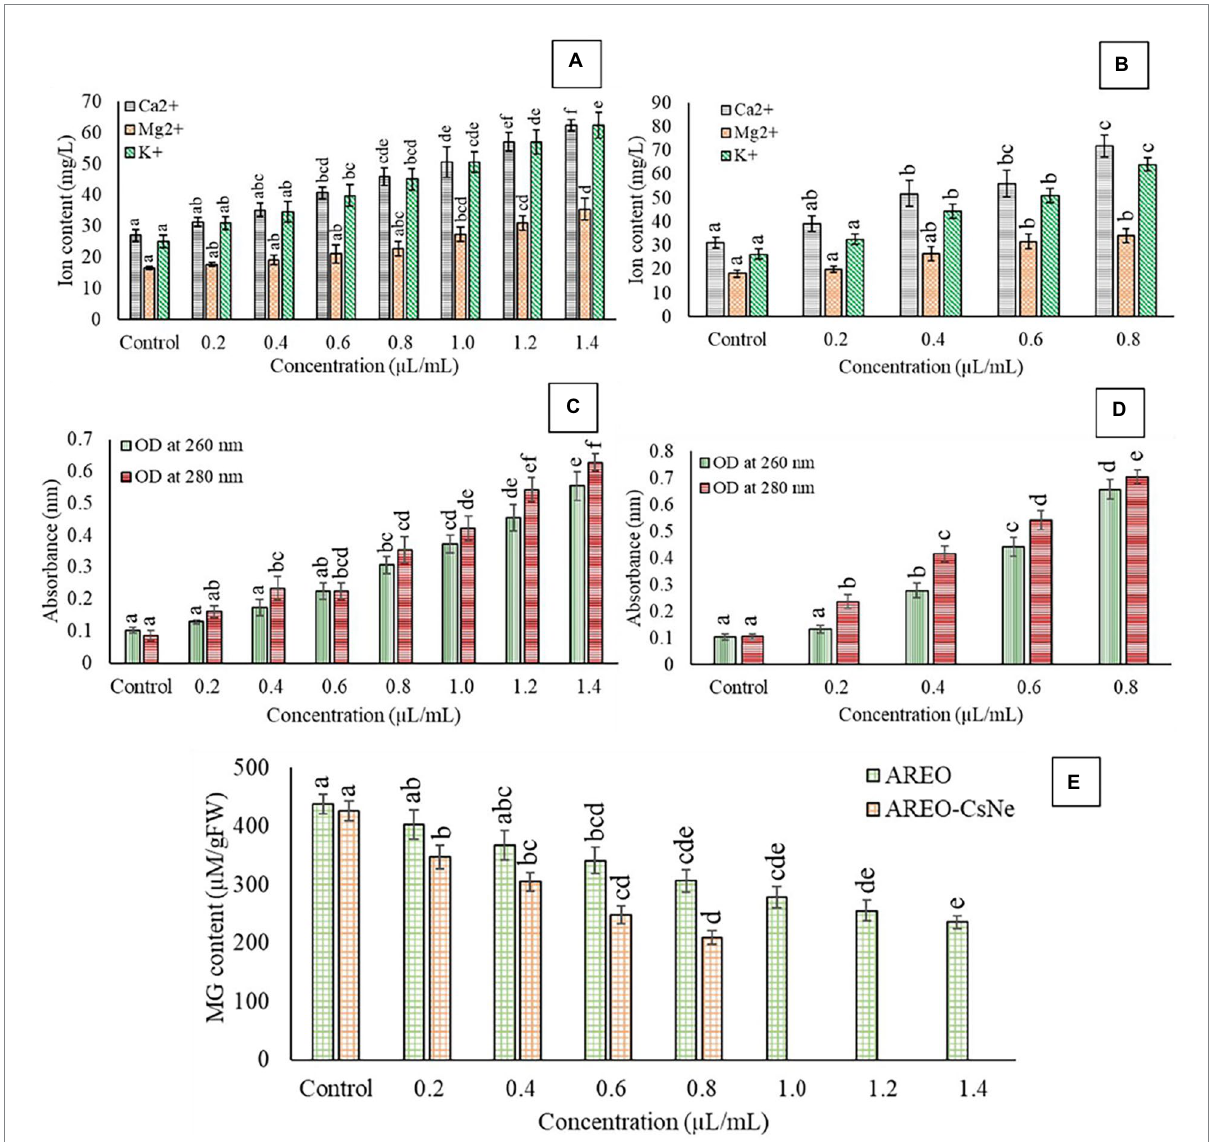
FIGURE 3 Effect of different concentrations of AREO (A) and AREO-CsNe (B) on cellular ions leakage (A,B) , effect of different concentration of AREO (C) and AREO-CsNe (D) on 260 and 280 nm absorbing materials leakage, and effect of on cellular methylglyoxal level of AFLHPSi-1 cells (E)